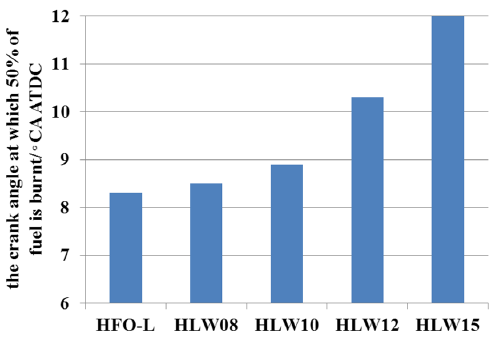
Figure 11. The crank angle at which 50% of the fuel is burnt.